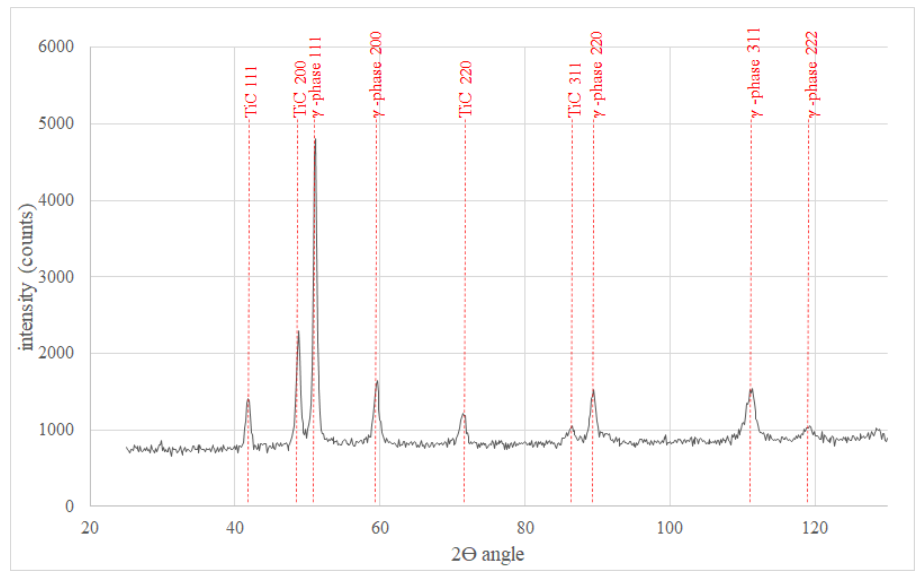
Figure 7. The XRD results of M-05 coating according to Table 3.